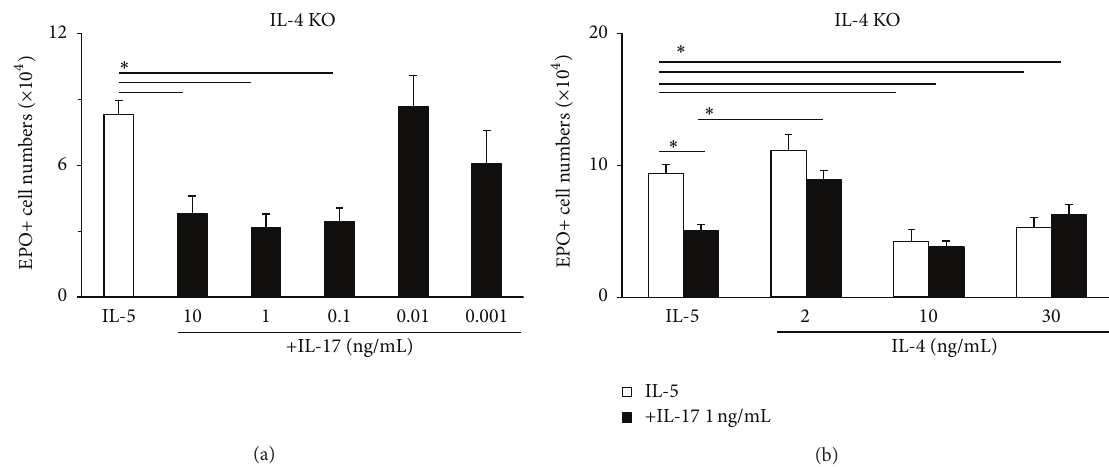
Figure 5: IL-4 attenuates the suppressive effects of IL-17A on eosinopoiesis. Bone-marrow cultures were established with IL-5, alone or in association with IL-17A, IL-4, or both, from IL-4-deficient mice of the BALB/c background mice, as described in legend of Figure 1. Data (mean + SEM) are the numbers of EPO+ cells recovered at day 7. (a) Concentration-response relationship for IL-17A with significant suppression down to 0.1ng/mL (comparing with Figure 1(a)). (b) Effect of adding IL-4 in different concentrations to cultures in the absence (white bars) and in the presence (black bars) of IL-17, 1 ng/mL. 2 ng/mL abolished the suppressive response to IL-17A, which is highly effective intheabsenceofexogenousIL-4.Dataaremean ± SEMofthenumbersofEPO+cellsrecoveredatday7. ∗ 𝑃 <